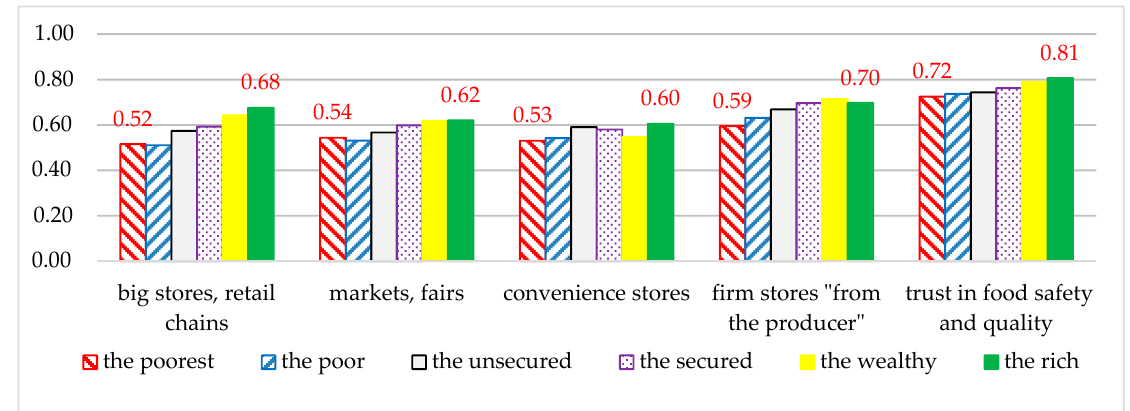
Figure 1. Index of trust in regional sales operators in terms of food quality and safety according to the respondent’s income. Source: Authors’ research.